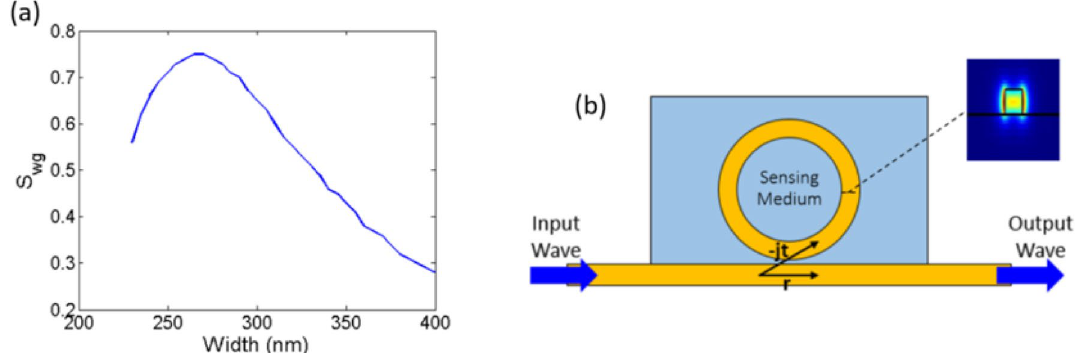
Figure 2. ( a ) S wg versus waveguide width w at λ = 1.55 µm. ( b ) Schematic of the MRR sensor; inset: electric field intensity profile of the used SOI waveguide (w = 320 nm) fundamental quasi-TE mode at λ = 1.55 µm.